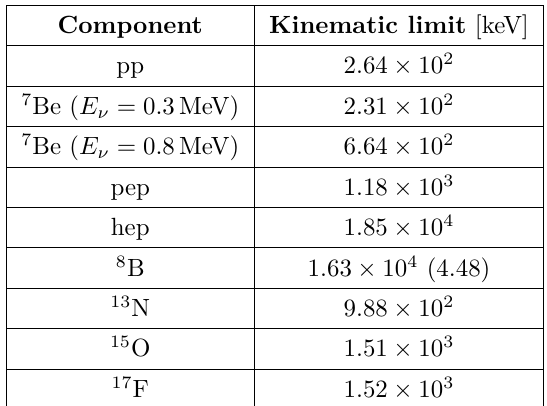
Table 1 . Kinematic recoil energy limit for the different neutrino components of the solar pp and CNO cycles in neutrino-electron scattering. Included as well in parenthesis is the kinematic limit for 8 B in CE ν NS. The values displayed follow from the BS05 standard solar model [23].